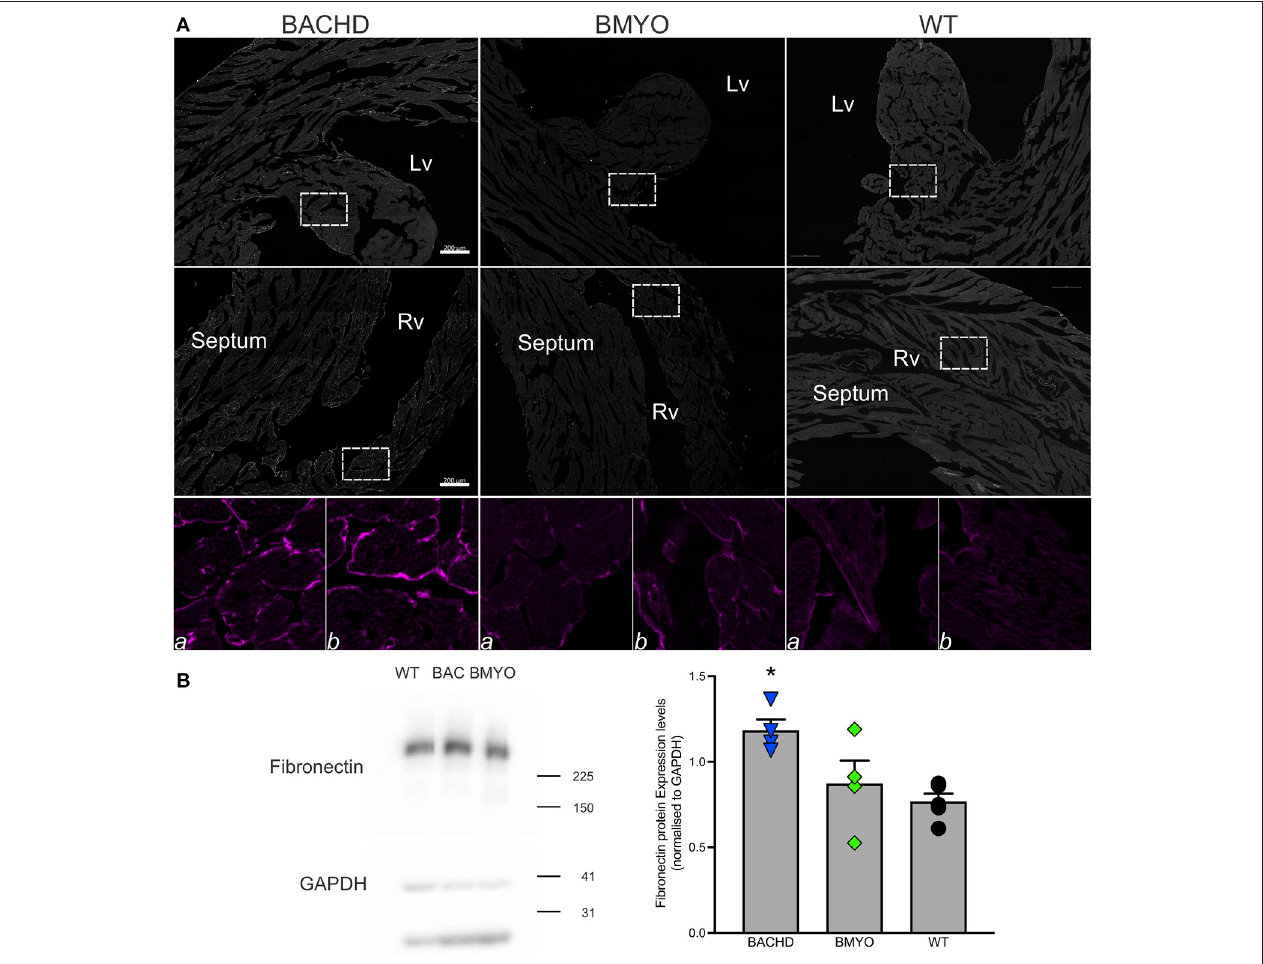
FIGURE 5 | The expression of fibrotic markers was diminished by the selective removal of human mHTT from the cardiomyocytes. (A) Representative images of immunostained mid-ventricular coronal heart sections showing stronger and diffuse expression of Collagen I in 6 months-old BACHD, but not in age-matched BMYO and WT mice ( n = 2 per genotype). The white rectangles delineate the areas where the enlarged images were obtained: (a) left ventricular wall-papillary muscle; (b) right ventricular wall. Intense collagen I immunoreactivity can be observed around the cardiomyocytes in the BACHD heart (left panels), but at a lower level in the BMYO and WT (middle and right panels, respectively). Lv, left ventricle; Rv, right ventricle. Scale bars = 200 µ m. (B) Representative western blotting of whole-tissue lysates of hearts from 6 months-old BACHD, BMYO and WT mice. The total protein levels of fibronectin displayed a significant increase in the BACHD mice as compared to WT. Each value derived from the densitometric analysis was corrected for background, and then divided by the sum of the background-corrected signals obtained in the same immunoblot. These values were then normalized to the respective relative GAPDH levels, which were corrected in the same manner. The vertical bar plots represent the group means and SEM. The symbols show the values for each individual animal (n = 4–5) per genotype. Kruskal-Wallis one-way ANOVA on ranks ( H = 6.003; P = 0.042) followed by Dunn’s multiple comparison test ( P = 0.045) was used to evaluate the possible significance of the findings. Asterisks represent significant differences ( P < 0.05) compared to WT